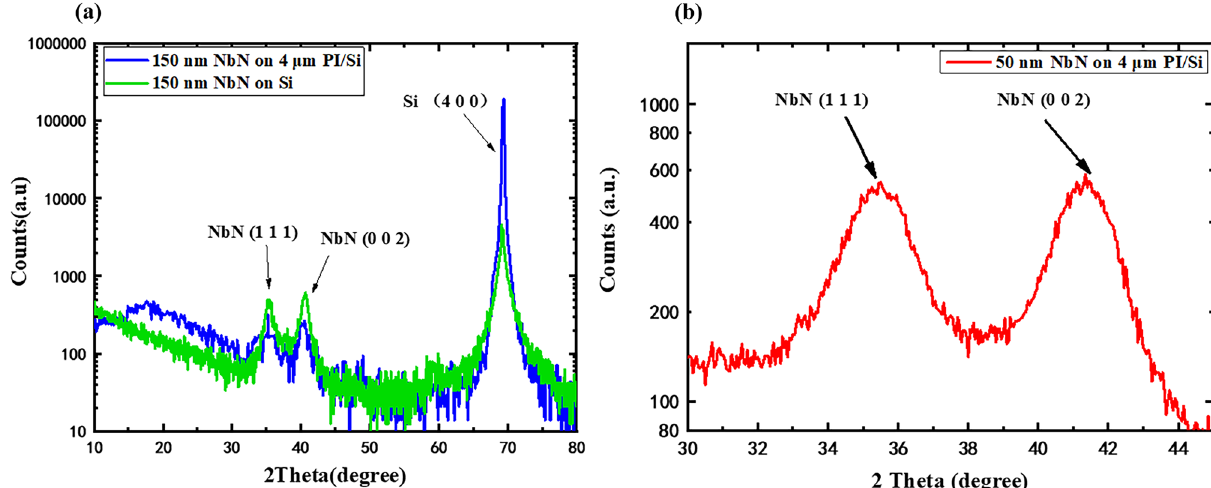
Figure 3. ( a ) XRD of 150 nm NbN on 4 μm PI with Si substrate and 150 nm NbN on Si substrate ( b ) GIXRD of 50 nm NbN on 4 μm PI/Si